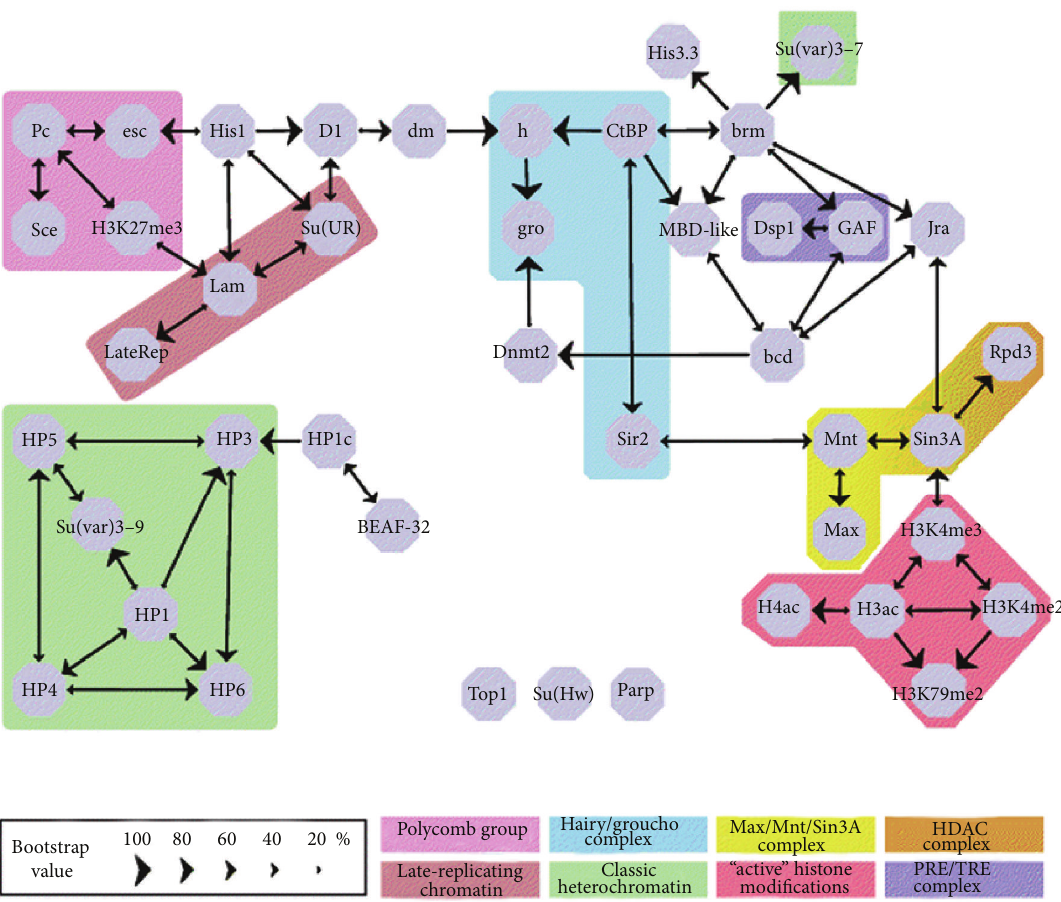
Figure 1: Bayesian Network model BN 80 of the targeting interactions between 43 chromatin components. Nodes represent chromatin components; edges represent predicted targeting interactions with a bootstrap score (combined for both directions) of at least 80%. The size of each arrowhead is proportional to the bootstrap score of the targeting interaction in the corresponding direction. (from [9]) With permission from Cold Spring Harbor Laboratory